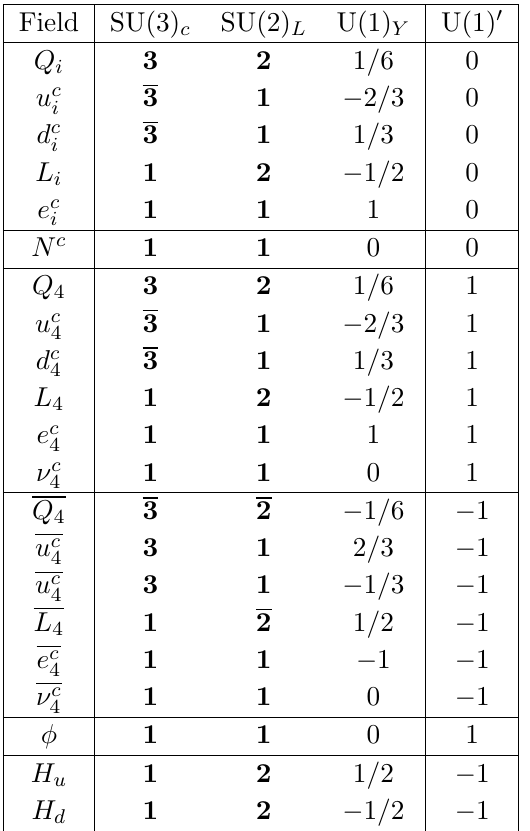
Table 2 . The most general model consists of three left-handed families conjugated right-handed (cid:12)elds c = u c ; d c ; e c ( i = 1 ; 2 ; 3), and a fourth vector-like family consisting i i i i of 4 plus 4 and c plus c , together with the U(1) 0 -breaking scalar (cid:12)eld (cid:30) and the two Higgs 4 4 scalar doublets H u and H d which are charged under U(1) 0 . In addition, a single CP conjugated right-handed neutrino N c is introduced. Notice that all the fermions of this table are left-handed spinors and the bars indicate conjugate representations under the SM gauge group.